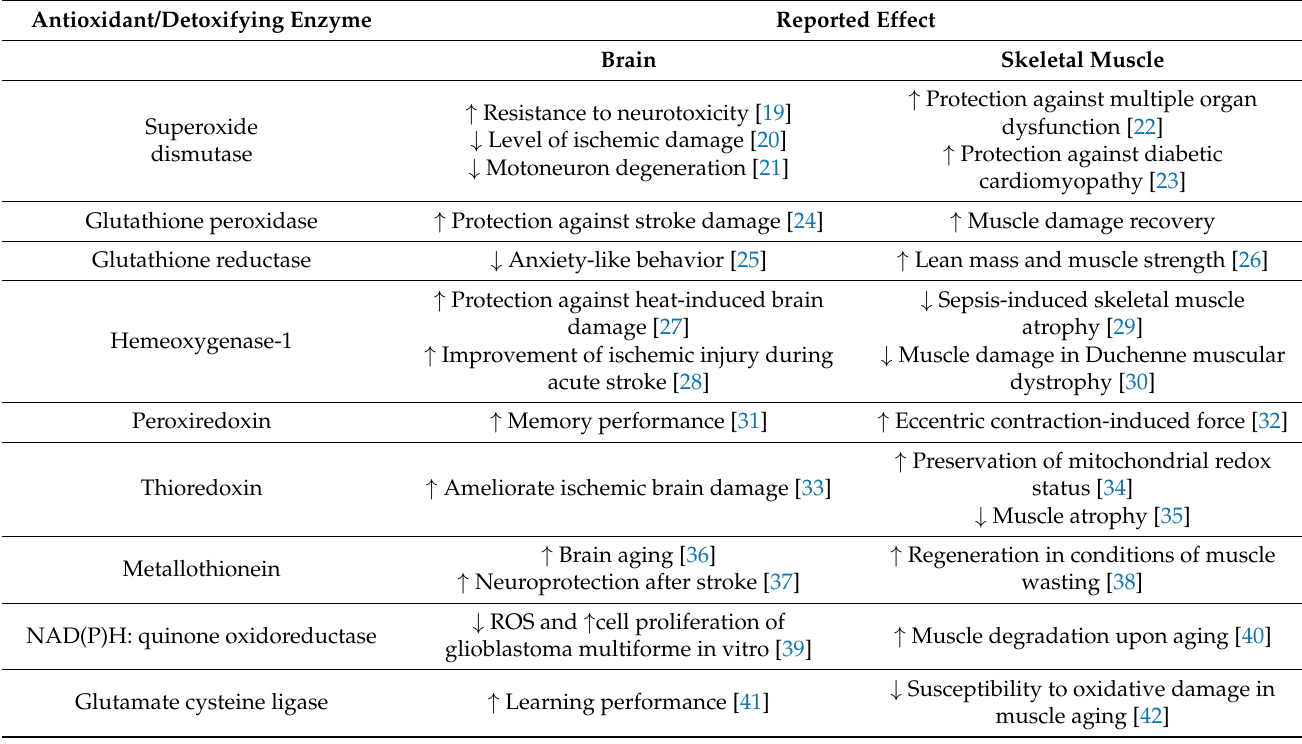
Table 1. The erythroid-related nuclear factor 2 (NRF2), antioxidant-responsive-elements (ARE) system, and enhanced enzyme activities in the brain and skeletal